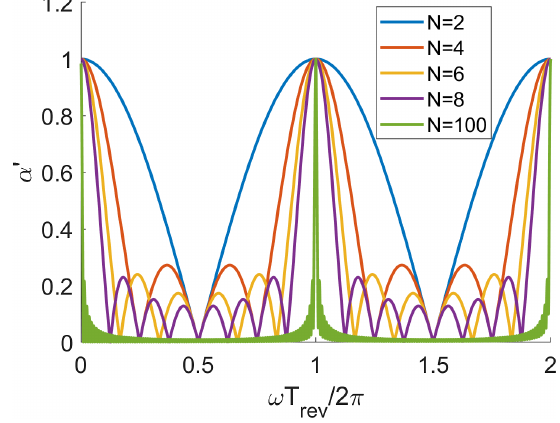
= 2 π for SP schemes for different numbers of FIG. 3. α 0 vs. ω T rev recirculation turns, with Q L assumed to be